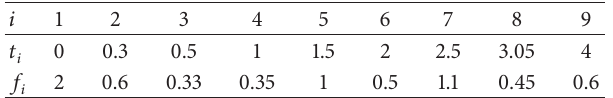
Table 6: 2D data set lying above the line 𝑦 = 0.05𝑥 + 0.23